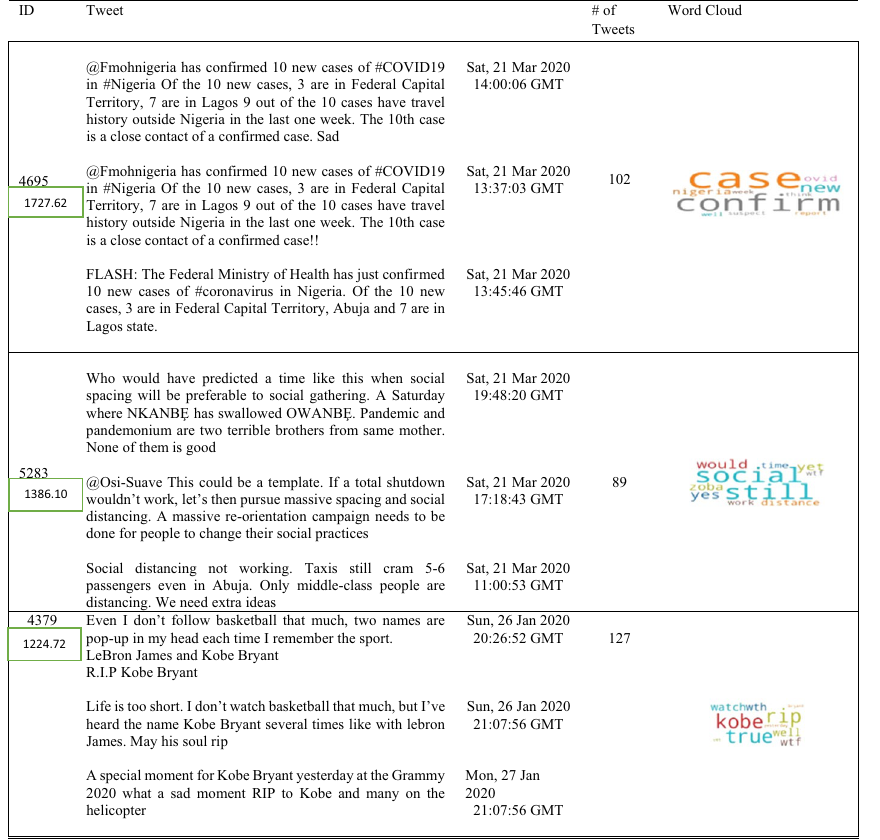
Table 16 Event Clustering, Ranking, and Summarisation ID Tweet # of